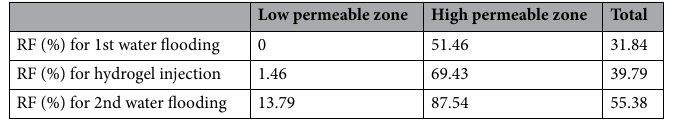
Low permeable zone High permeable zone Total